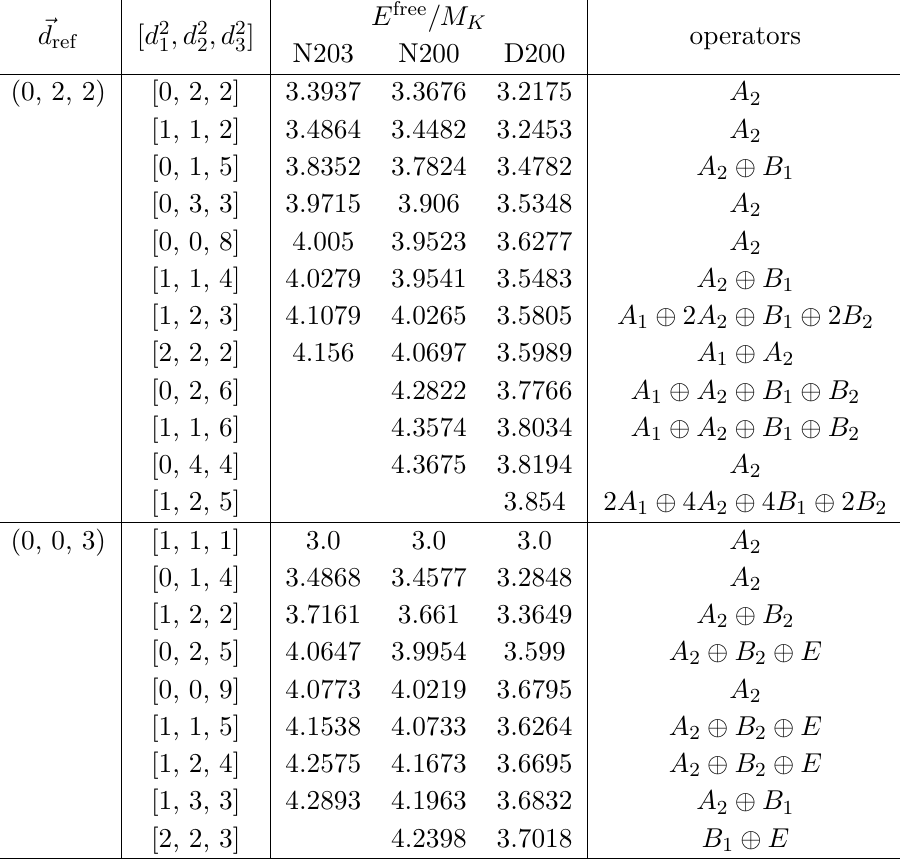
Table 26. Same as table 21 except for the three-kaons operators with 8 ≤ ~d 2